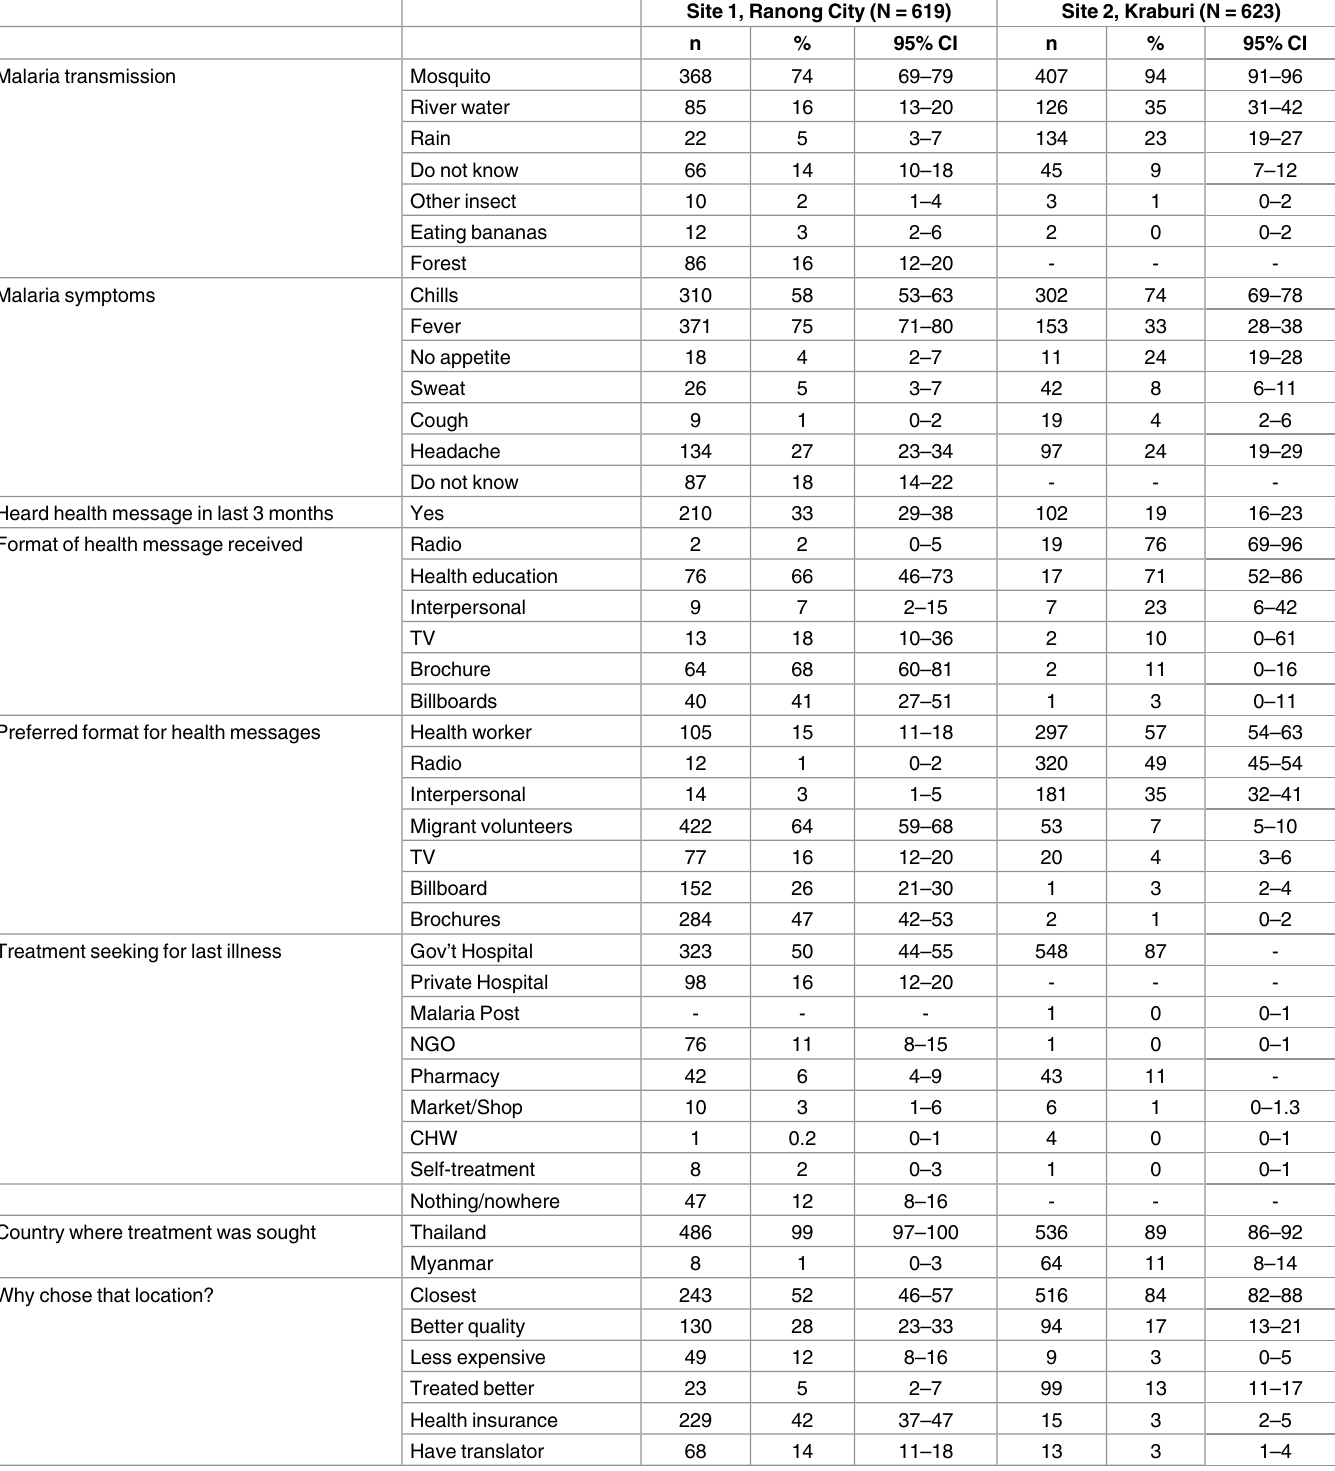
Table 3. RDS-weighted estimates of malaria knowledge, exposure to health messages,and treatment-seeking behavior by